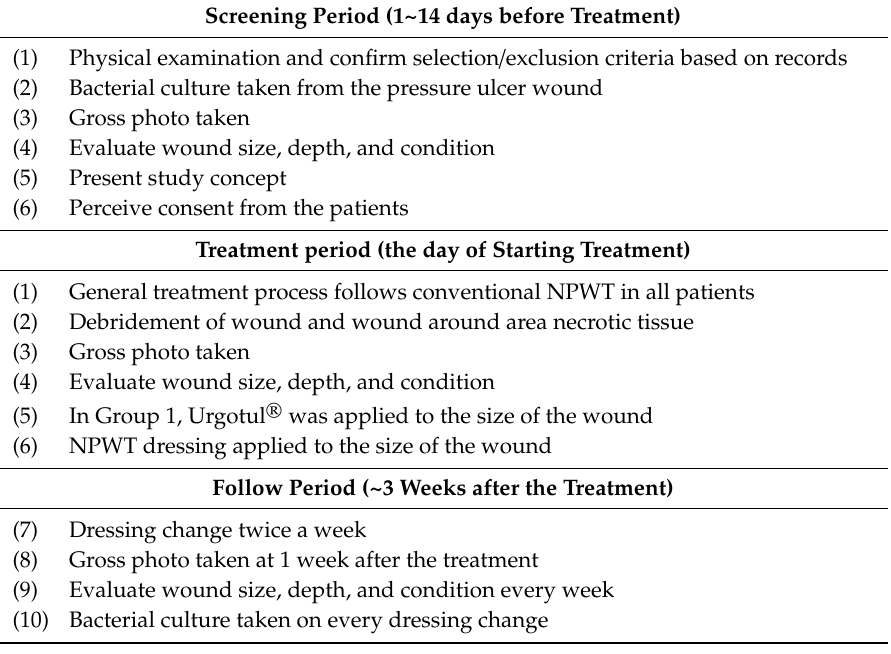
Table 1. Study timeline. Measurements were taken at three di ff erent time points. Physical examination and evaluation of the wound were performed according to the corresponding protocol at each time